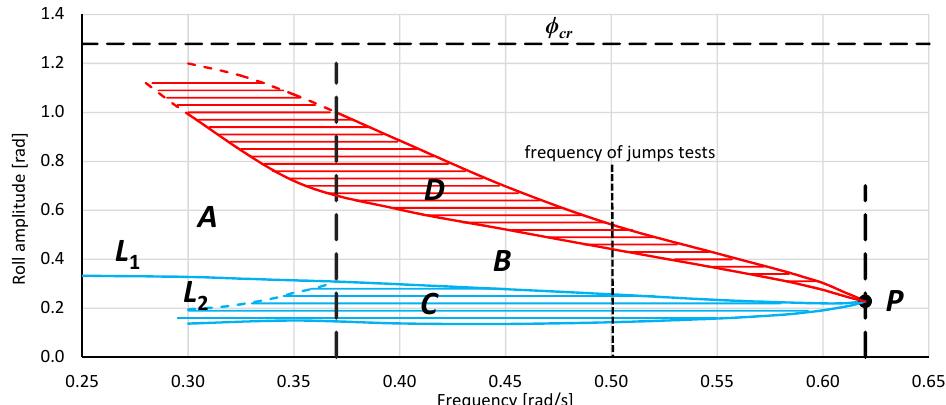
Figure 6. Areas of bistability and unstable solution of the mathematical model of rolling for the offshore support vessel ( T = 6.10 m, GM 0 = 2.50 m).